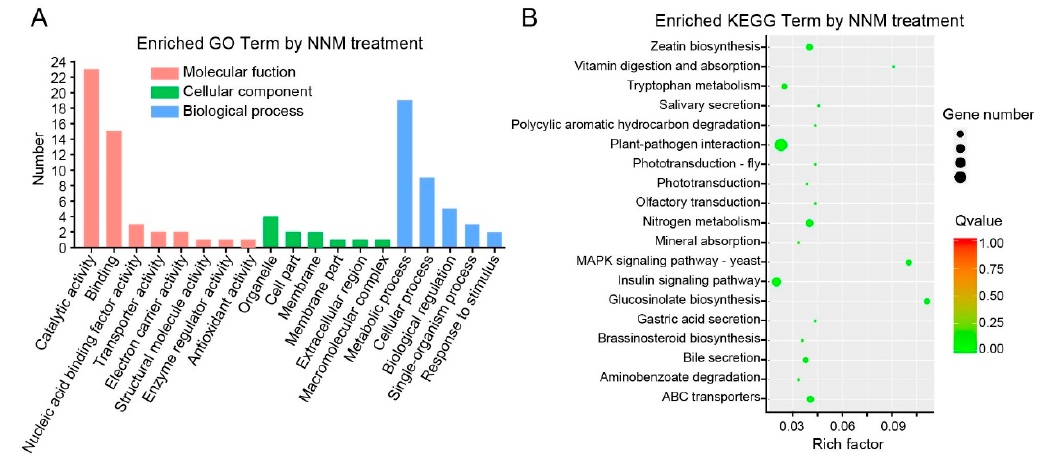
Figure 3. DEGs enriched in Gene Ontology (GO) and Kyoto Encyclopedia of Genes and Genomes (KEGG) analysis induced by NNM. ( A ) GO terms of three categories significantly enriched in DEGs of NNM vs. CK involved in molecular function, cellular component, and biological process. ( B ) KEGG pathways of the significantly enriched DEGs. The rich factor reflects the degree of enriched DEGs in a given pathway. The number of enriched DEGs in the pathway is indicated by the circle area, and the circle color represents the ranges of the corrected p-value.